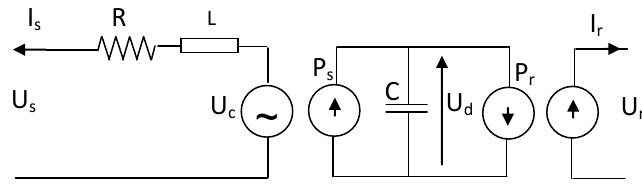
Figure 6. Equivalent circuit of the back-to-back converters in the DFIG.